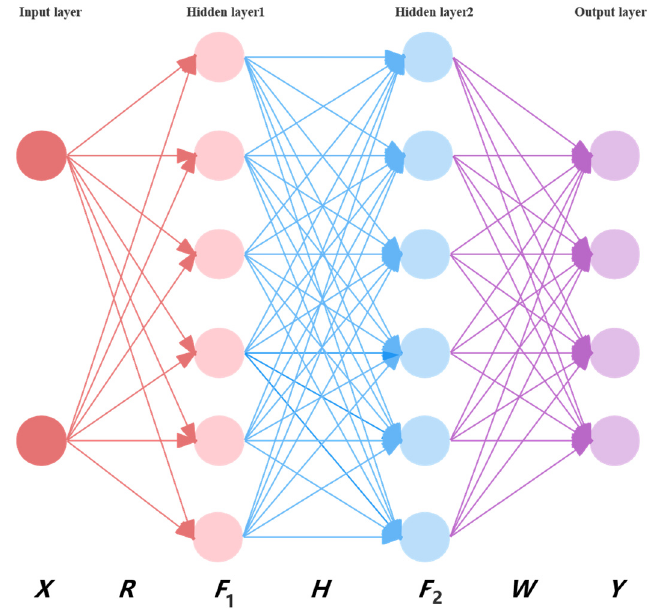
Figure 3. Schematic of the four-layered, a fully connected neural network consisting of 18 computational units used in this study.